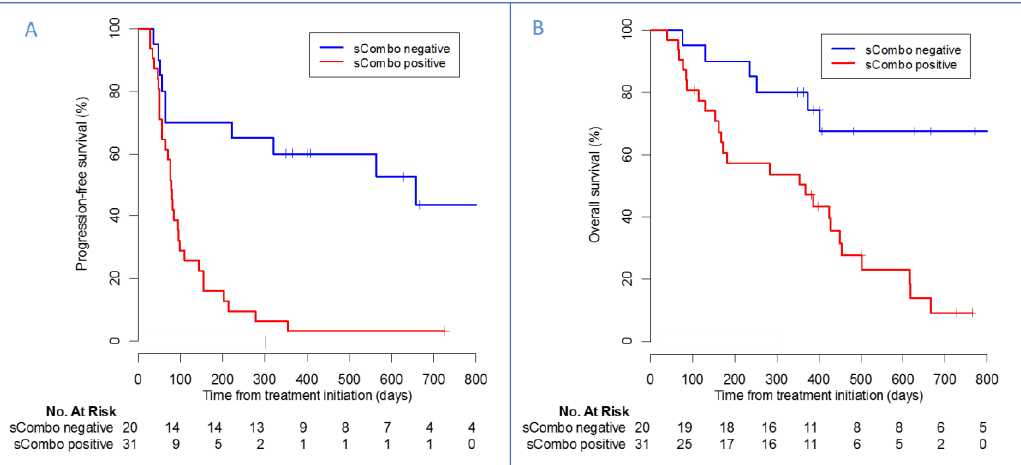
Figure 2. Kaplan–Meier estimates of patients’ ( A ) progression-free survival and ( B ) overall survival according to sCombo status.